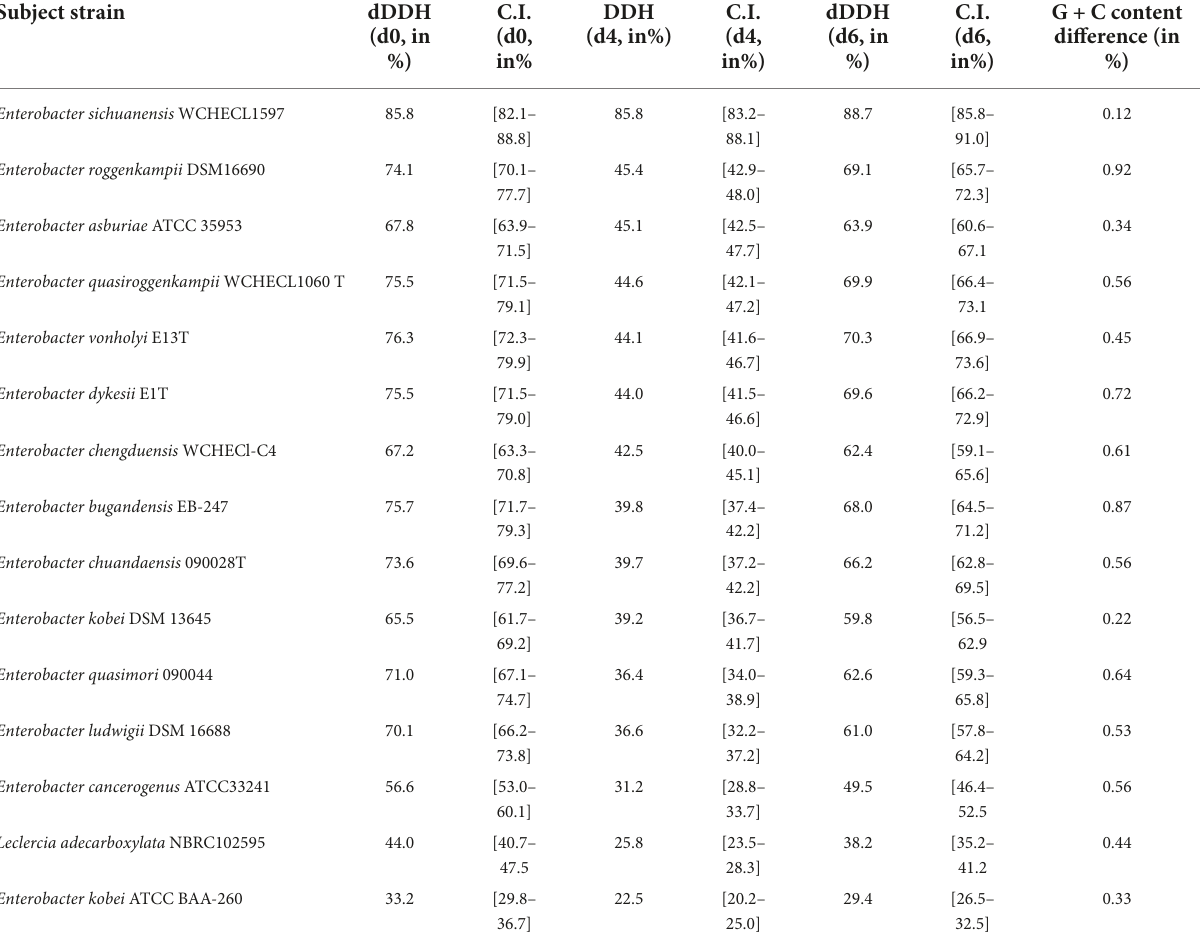
TABLE 4 Digital DNA–DNA hybridization (dDDH) for species determination of Enterobacter sp. HSTU-ASh6 depends on whole genome